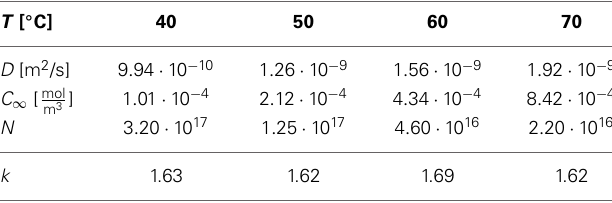
Table 2 | Representative material parameters for the synthesis of monodisperse AgBr particles [adapted from 51] and the corresponding k values as calculated via Equations (35).